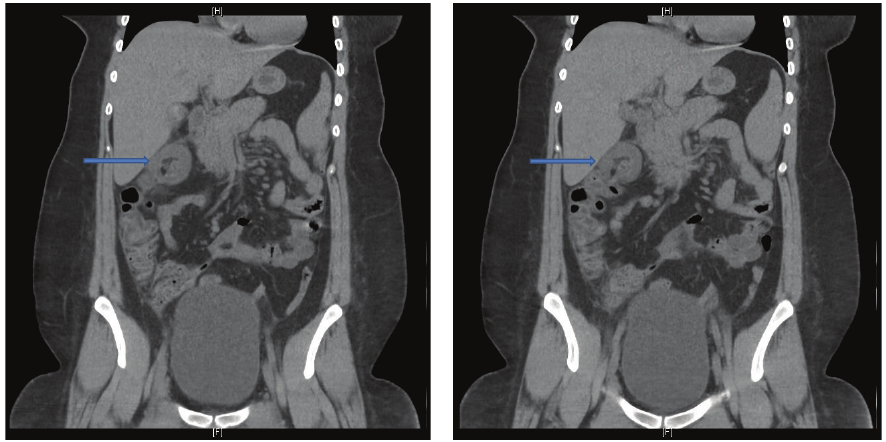
Figure 1: CT abdomen demonstrating colocolic intussusception at the hepatic flexure